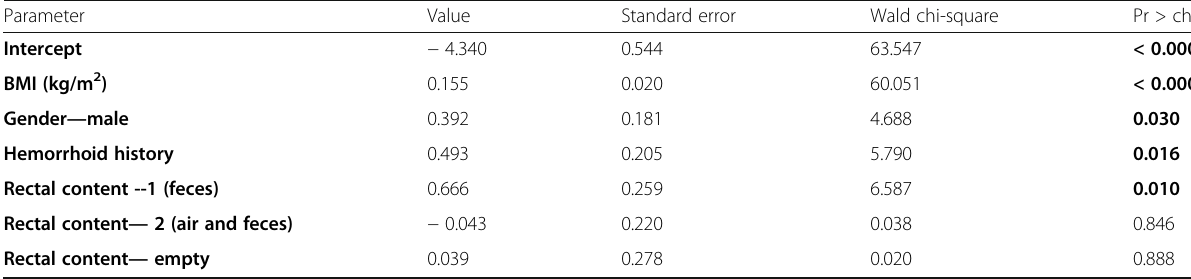
Table 4 Logistic regression analysis of risk factors for anal canal hypermetabolism